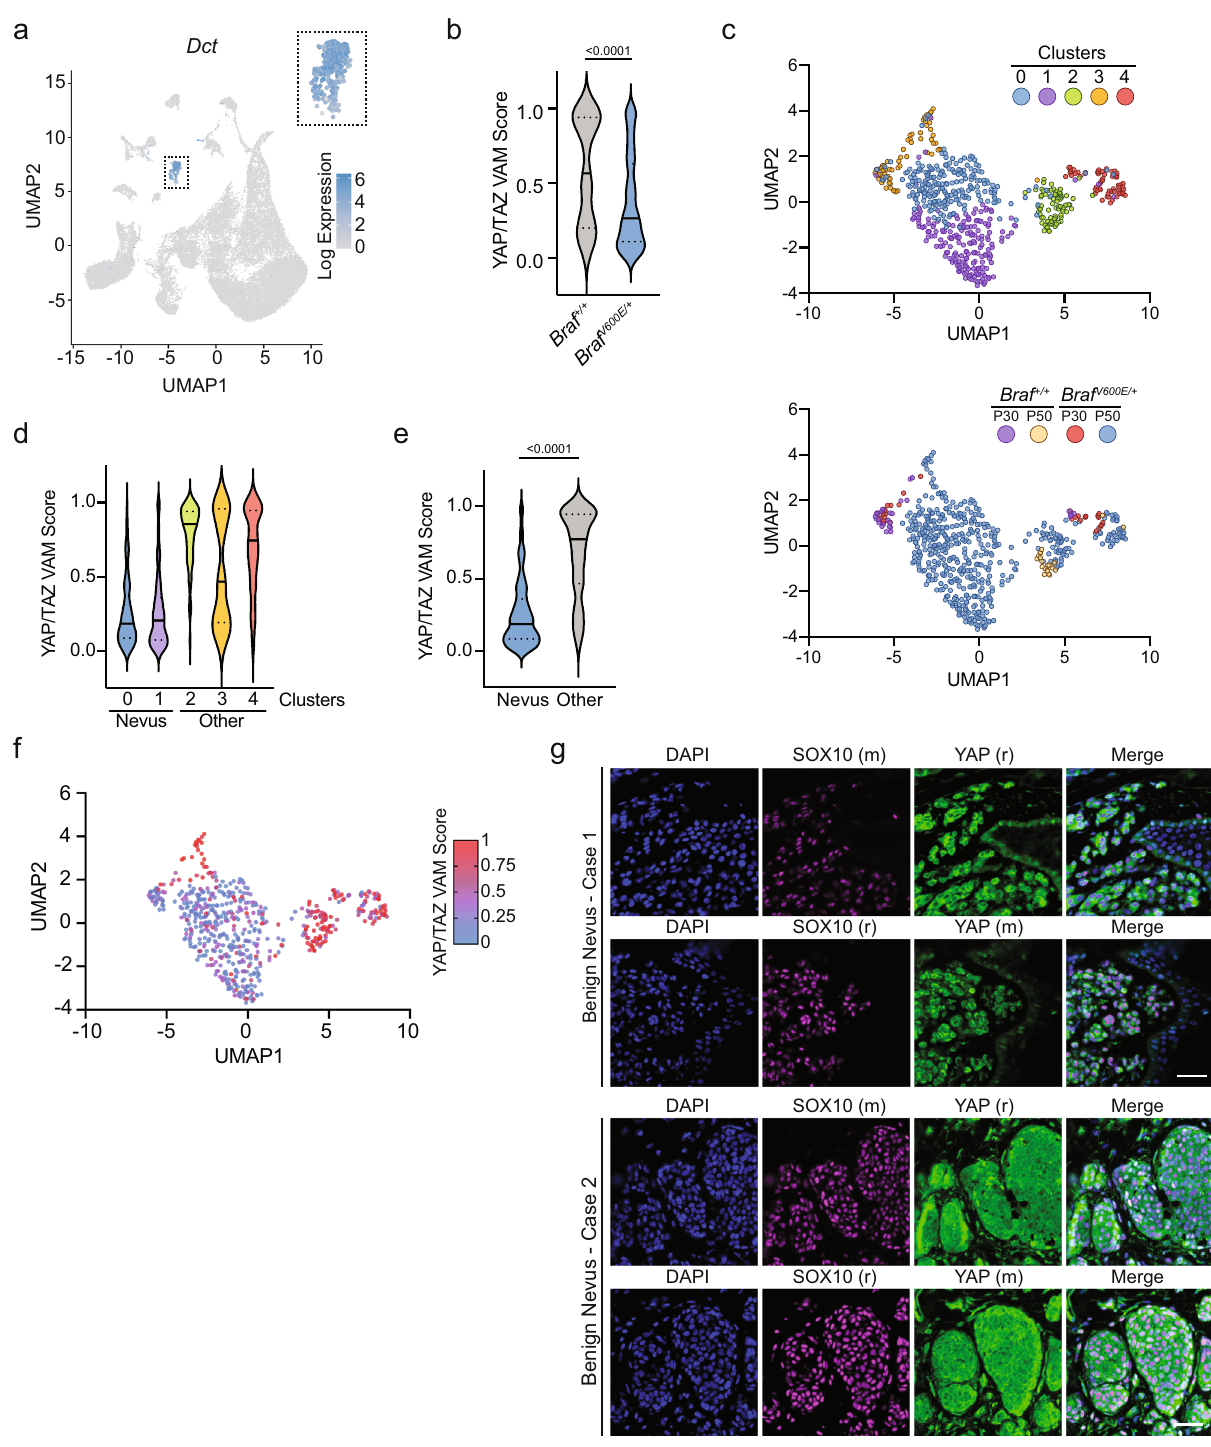
Fig. 2 Braf V600E -expressing nevus melanocytes display decreased YAP/TAZ signaling. a UMAP of relative Dct expression of all single cells from nevus containing murine skin identifying a cluster of cells representing melanocytes from GSE154679. b YAP/TAZ VAM scores for melanocytes from indicated genotypes ( n = 46 for Braf + / + , n = 543 for Braf V600E/ + , two-tailed Mann – Whitney test). c Top, UMAP of melanocytes colored by subcluster; Bottom, UMAP of melanocytes colored by genotype and animal age ( n = 589). d YAP/TAZ VAM score plotted by melanocyte subcluster. e YAP/TAZ VAM score comparing nevus (clusters 0, 1) and other melanocytes (clusters 2, 3, 4) (nevus n = 408, other n = 181, two-tailed Mann – Whitney test). f UMAP of melanocytes colored by gradient indicating YAP/TAZ VAM score. g Representative immuno fl uorescence staining of indicated proteins in two benign nevi cases with two different sets of antibodies, (r) = rabbit, (m) = mouse, DAPI (blue), YAP (green), SOX10 (magenta), scale bar = 50 µ m. Source Data are provided as a Source Data fi